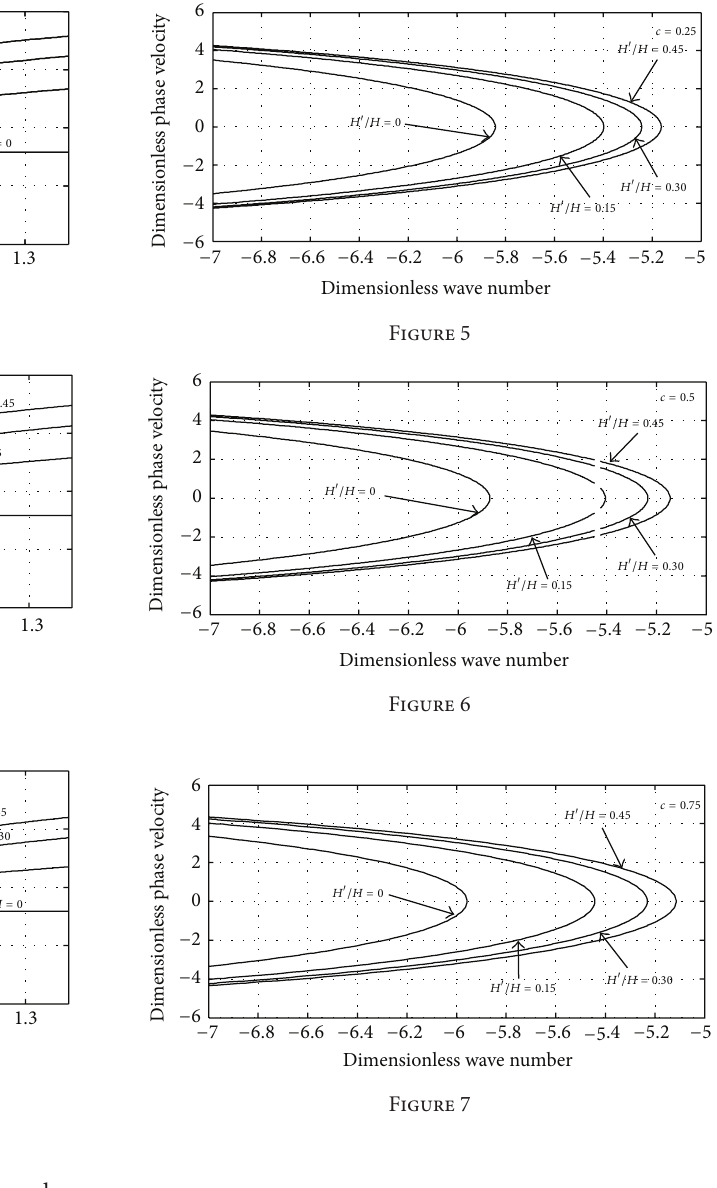
variations of the dimensionless phase velocity ( 𝑐/𝑐 𝐺 ) against the dimensionless wave number ( 𝑘𝐻 ) in an elastic isotropic homogeneous layer over a homogeneous elastic half-space for different values of 𝐻 󸀠 /𝐻 (0, 0.15, 0.30, 0.45) and 𝑐 = 0.25 , 𝑐 = 0.5 , and 𝑐 = 0.75 are shown in Figures 2, 3, and 4. Case II . When 𝐻 1 = 0 which is the wave propagation in a transversely isotropic fluid saturated porous layer lying over a homogeneous half-space, the variations of the dimensionless phase velocity ( 𝑐/𝑐 𝐺 ) against the dimensionless wave number ( 𝑘𝐻 ) in a transversely isotropic fluid saturated porous layer over a homogeneous elastic half-space for different values of 𝐻 󸀠 /𝐻 (0, 0.15, 0.30, 0.45) and 𝑐 = 0.25 , 𝑐 = 0.5 , and 𝑐 = 0.75 are shown in Figures 5, 6, and 7. The dimensionless phase velocity ( 𝑐/𝑐 𝐺 ) is plotted against the dimensionless wave number ( 𝑘𝐻 ) in Figures 2, 3, 4,